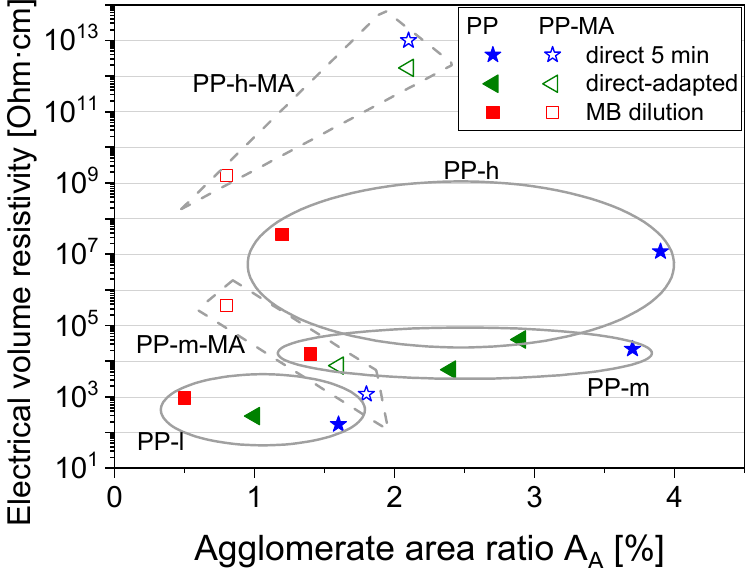
Figure 5. Electrical volume resistivity vs. state of macro dispersion (A A ) for unmodified PP/2 wt % MWCNT composites, circles and polygons are only for guiding the eyes.